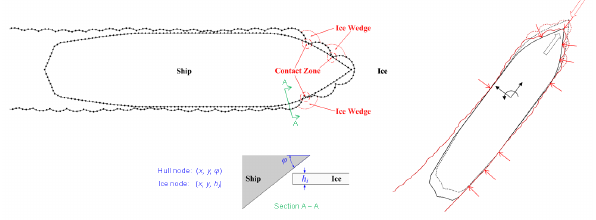
Figure 3: Illustration of the numerical ice-hull interac- tion model (Su et al.,